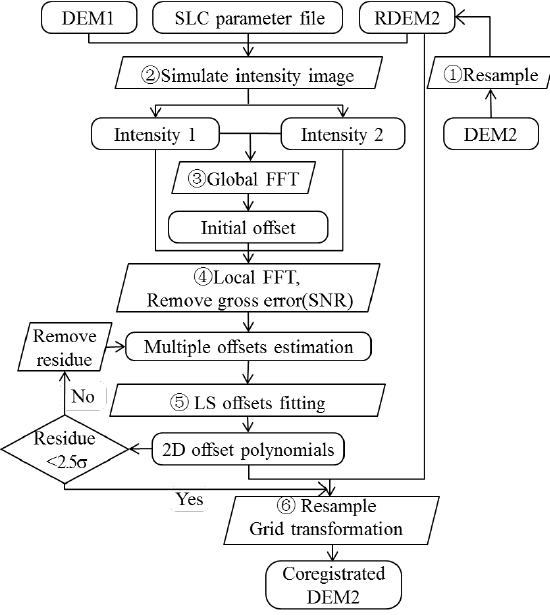
Figure 2. Schematic plan of Figure 3. SAR imaging normal surface